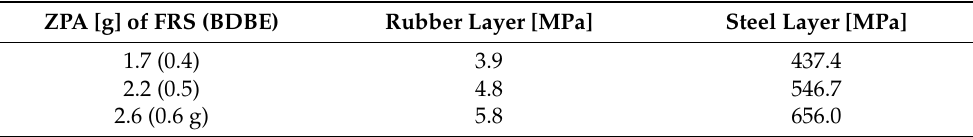
Table 4. Analysis results of max. equivalent stress on the rubber and steel layers.